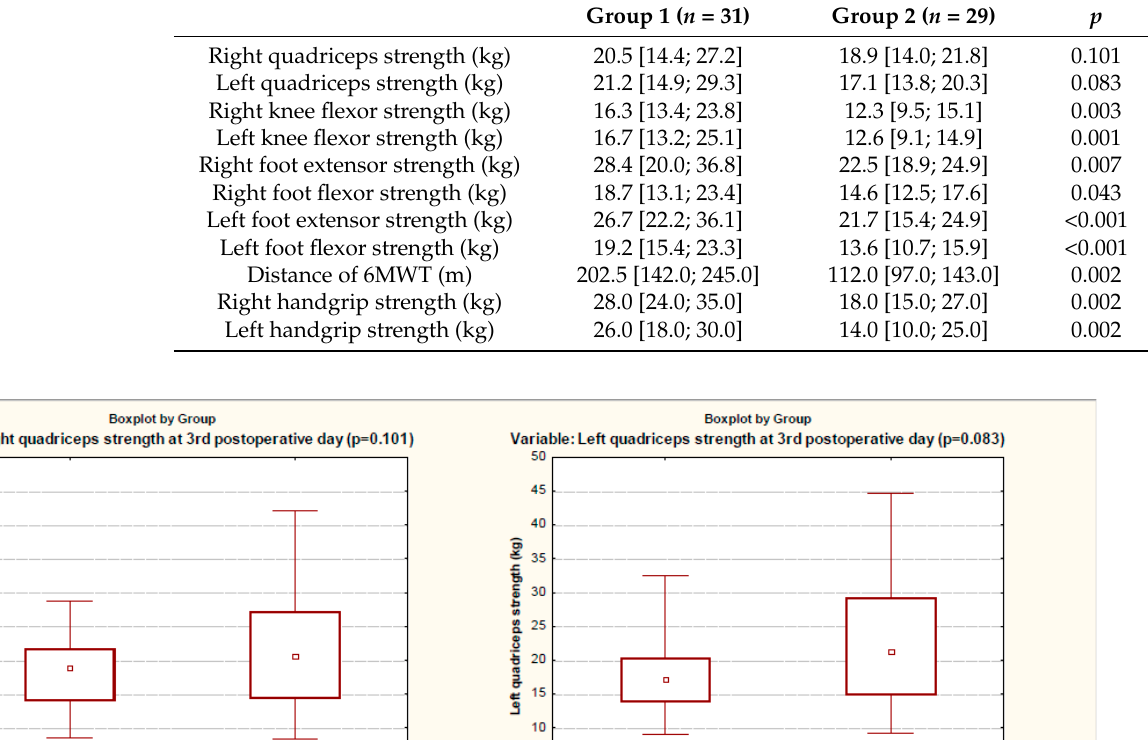
Table 2. Muscle status on postoperative day 3 in groups.